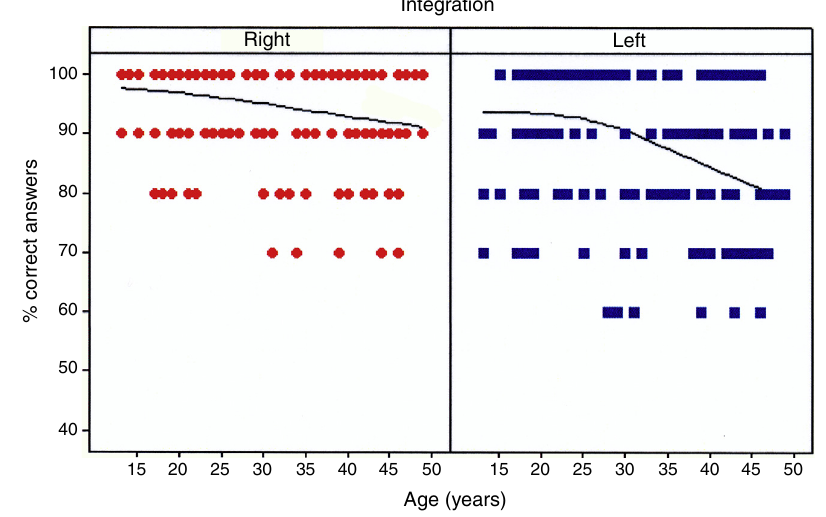
Figure 2 Scatter plots of correct answer percentages in the integration stage by age and